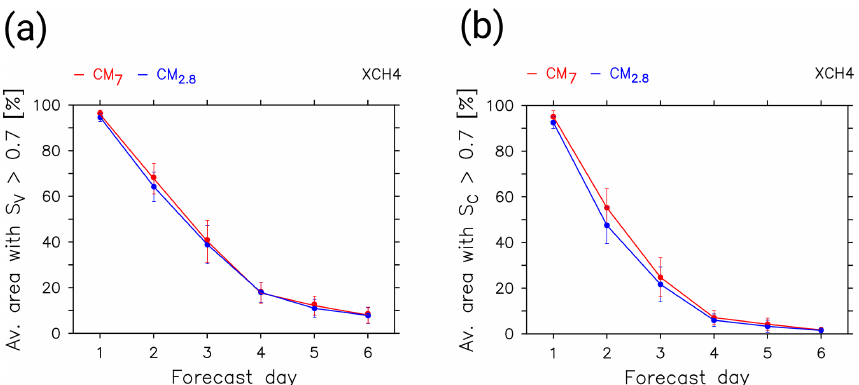
Figure 14. The graphic shows the evolution of the theoretical forecast skill with increasing forecast day for CM7 (red) and CM2.8 (blue). The vertical axis displays the average area (%), according to the smallest model domain, with a skill score > 0 . 7. The horizontal axis shows the specific forecast days one to six. The skill scores are calculated for each day at each grid point from 1 to 22 June 2018 (CoMet 1.0). The CH4_FX total-column mixing ratios of the forecast simulations are compared to the CH4_FX total-column mixing ratios of the analysis simulation. The error bars indicate the interval which contains 95% of all skill scores per day. S V (a) emphasizes variability and S C (b) emphasizes the correlation.